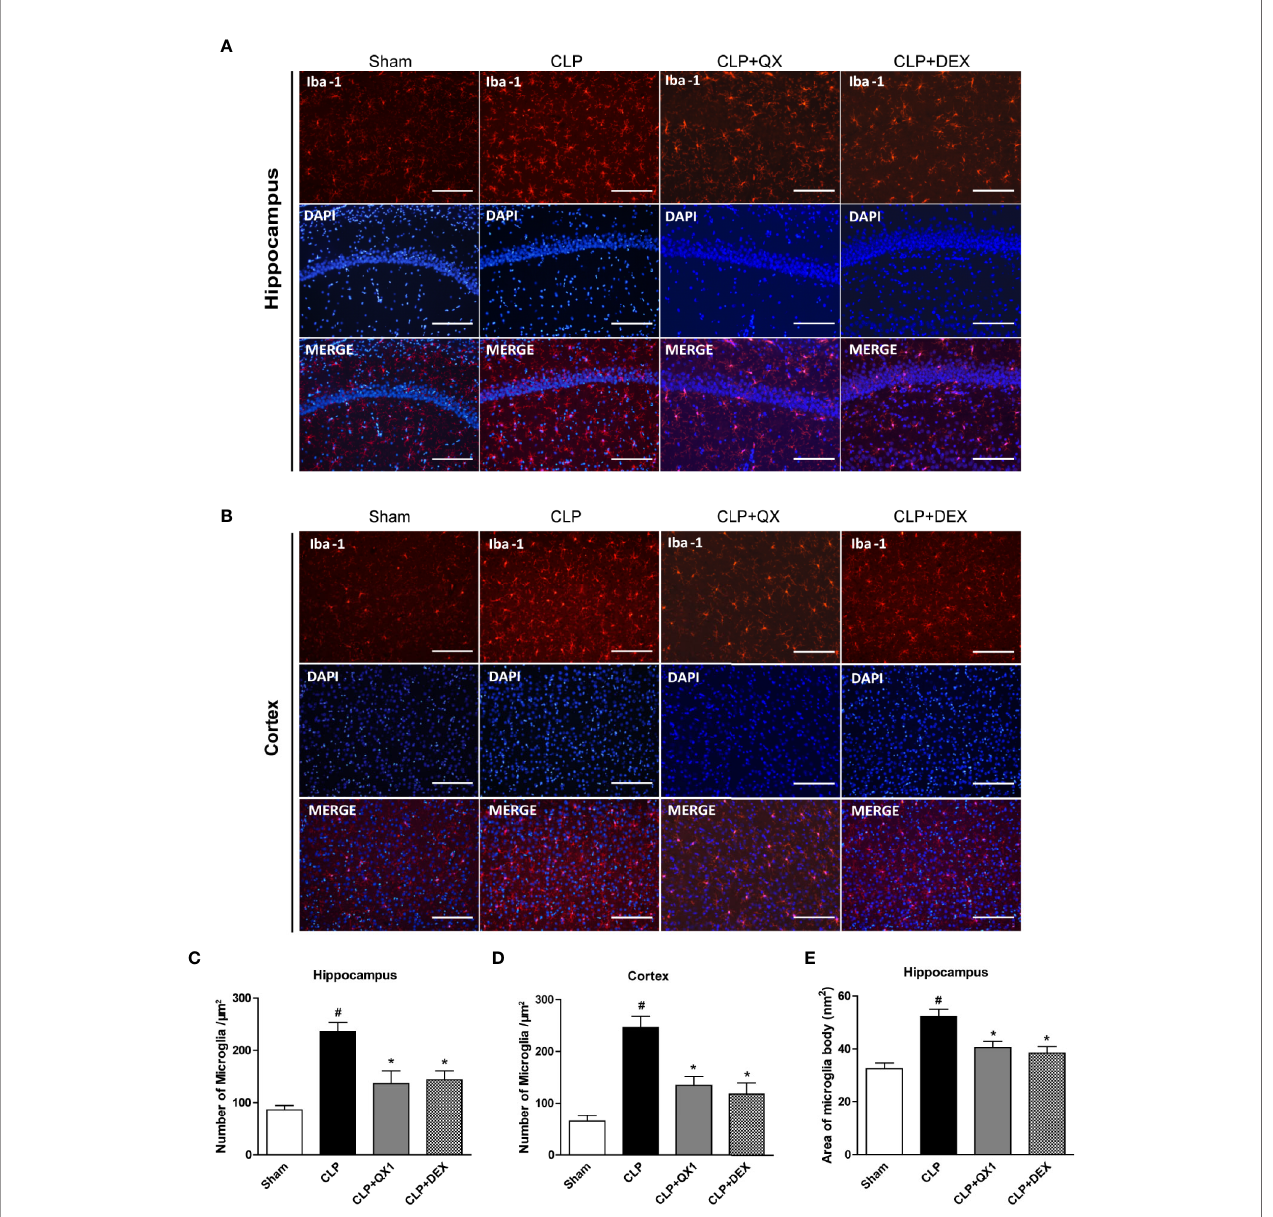
FIGURE 6 | QX1 formula reduces microglia activation in septic mice. Representative Iba-1 and DAPI immuno fl uorescence staining in (A) the CA1 area of the hippocampus and (B) the frontal cortex in mice treated with QX1 formula or DEX beginning at 2 h after CLP surgery. Scale bar = 100 m m. (C, D) Statistical analysis of Iba-1 positive cell counts in the hippocampus and the frontal cortex. (E) Statistical analysis of Iba-1 positive cell body area in the hippocampus (n=10 per group, three slices per animal). Data were shown as mean ± SD. # p < 0.05 vs. sham, * p < 0.05 vs. CLP, one-way ANOVA. QX1, Qiang Xin 1; CLP, Cecal Ligation and